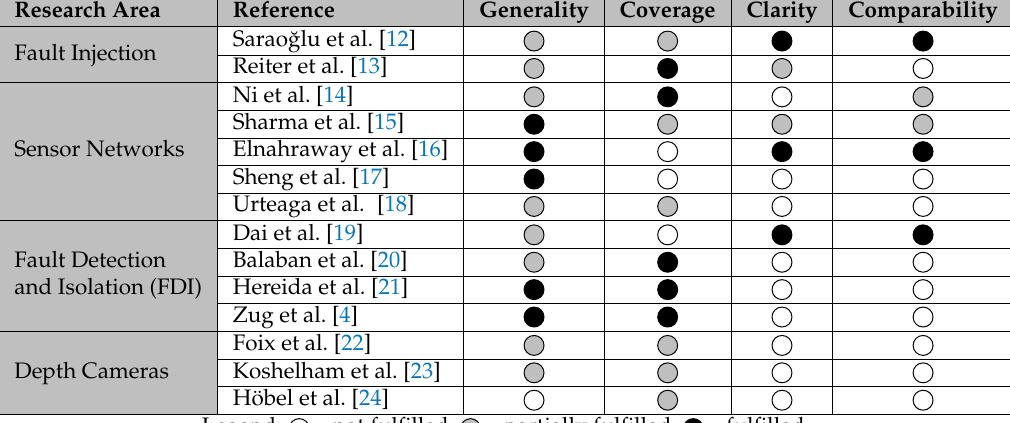
Table 1. Overview on the fulfillment of the predefined requirements by individual approaches of the state of the art on sensor failure